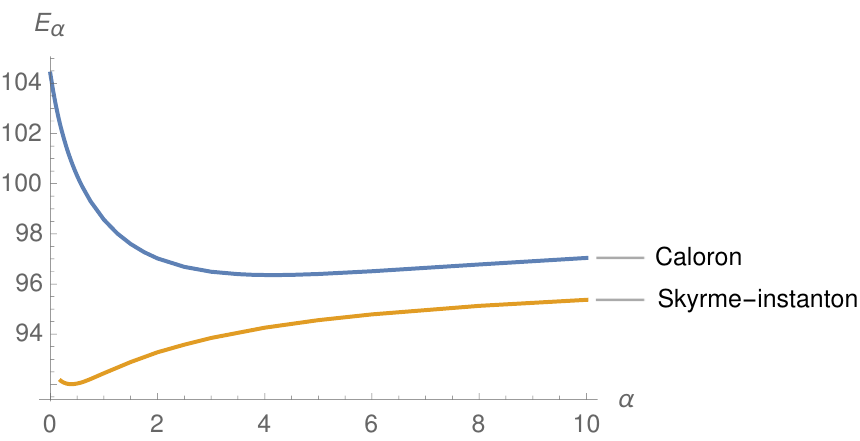
Figure 8. The energies E (cid:11) for the optimal Harrington-Shepard caloron and the numerical Skyrme- instanton minimisers.